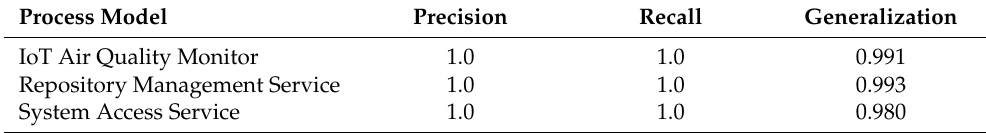
Table 4. Results of the quality metrics applied in the business process models discovered.